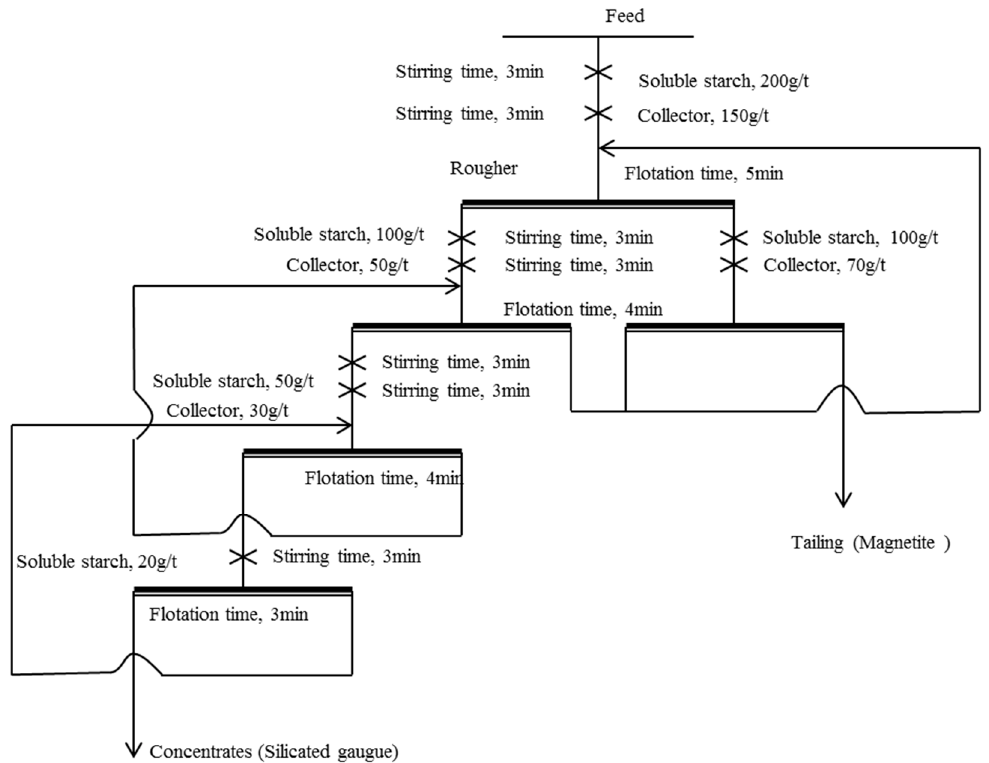
Figure 2. The locked cycle flowsheet of Bench-scale flotation experiments.